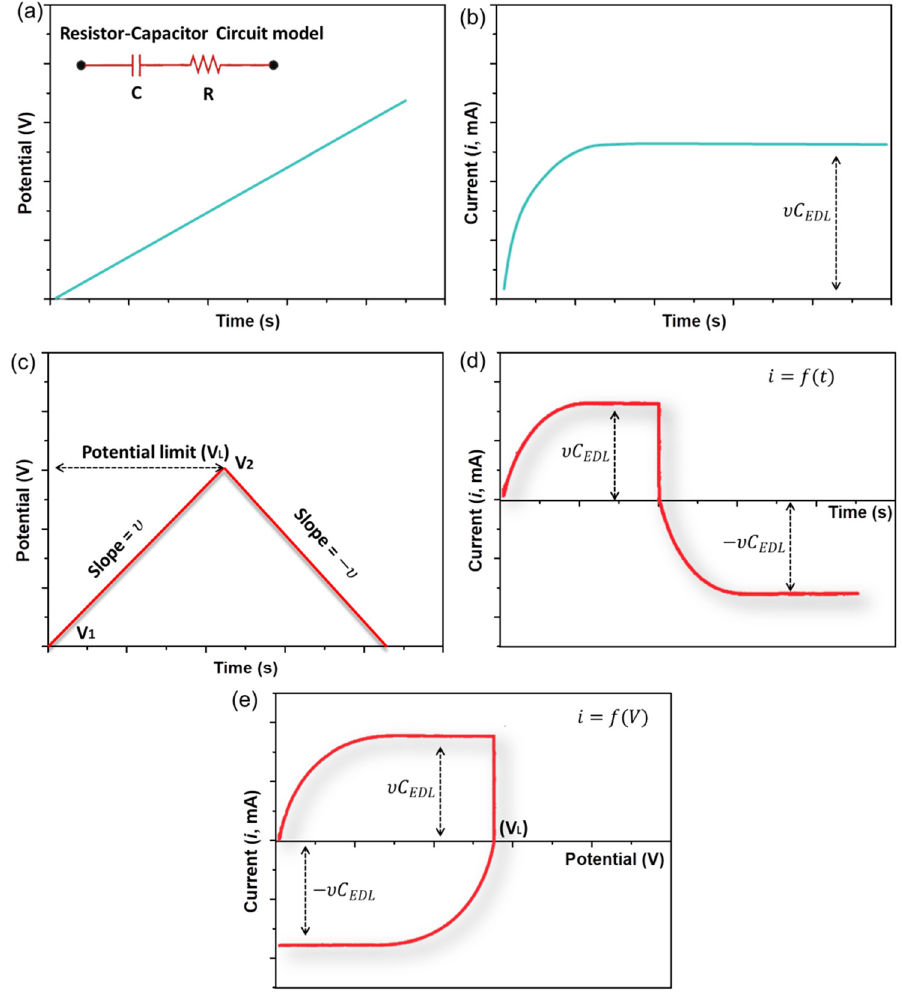
Figure 7. Plots of ( a ) a linear potential sweep (inset shows the pictorial representation of a simple resistor–capacitor (RC) circuit model) and ( b ) its current response ( i ) as a function of time ( t ). ( c ) Behavior of a triangular potential sweep ( υ and − υ ) applied to the RC circuit. Plots showing the resultant responses of the circuit as ( d ) current vs. time and ( e ) current vs. applied potential.